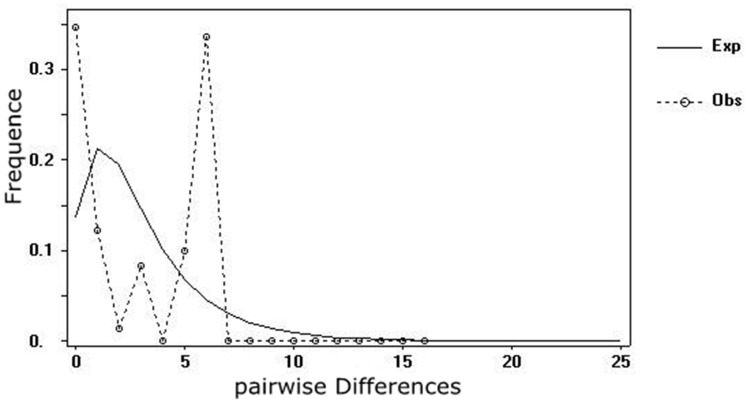
Mismatch distributions of cpDNA haplotypes based on pairwise sequence difference plotted against the frequency of occurrence.